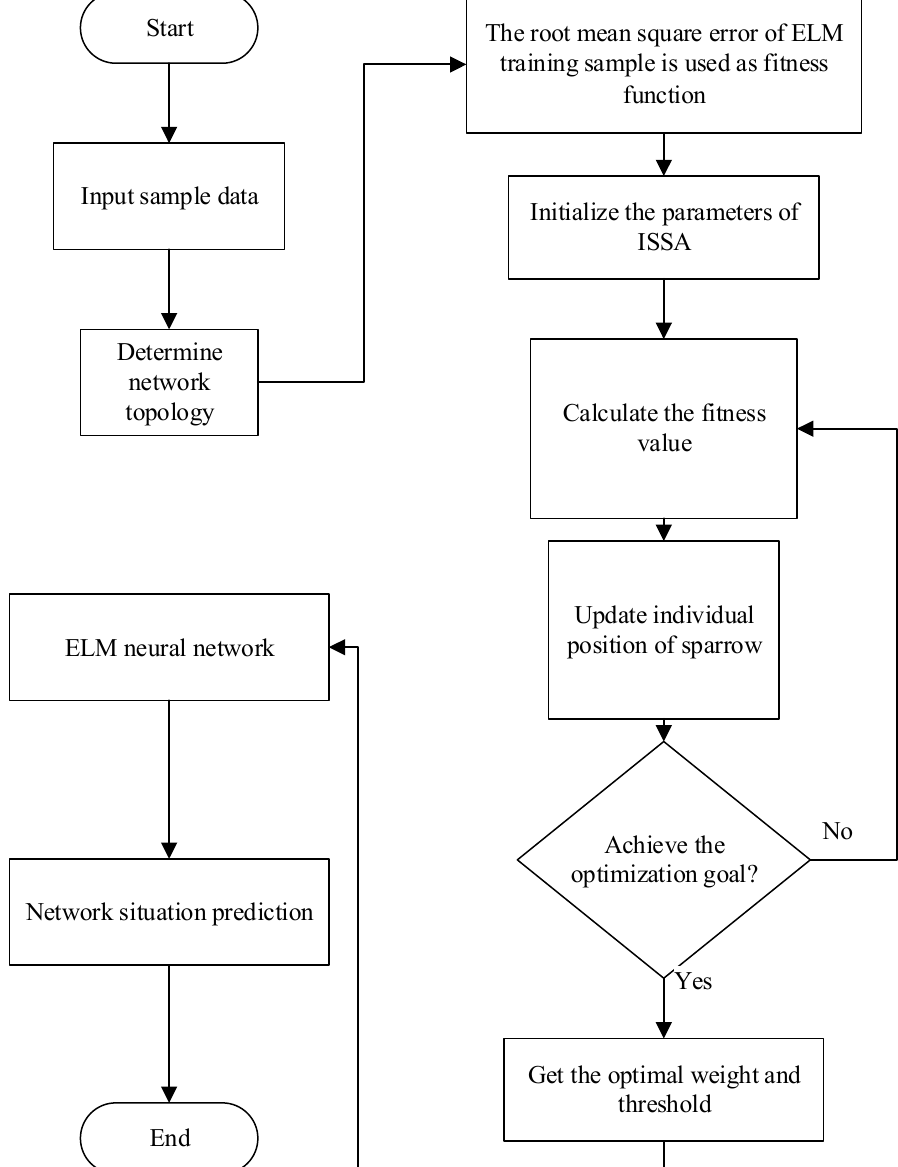
Figure 4. Flow chart of ISSA-ELM prediction.